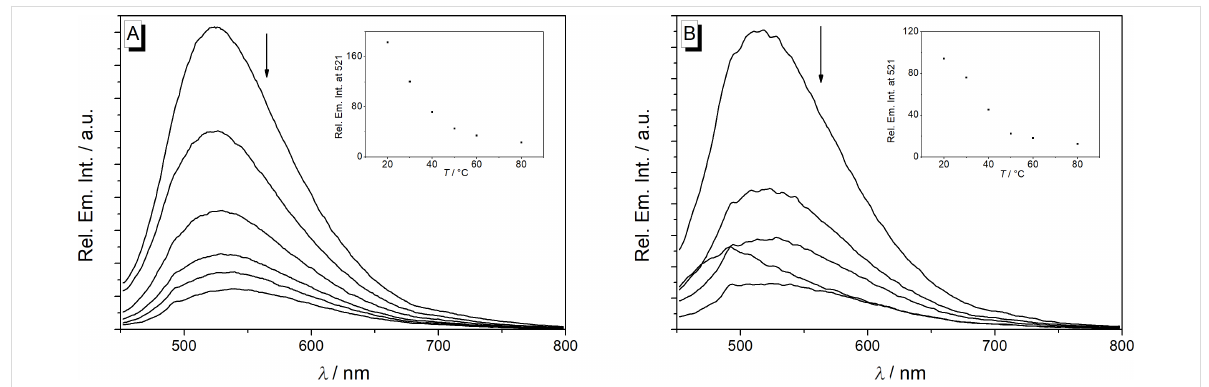
Figure 2: Temperature dependent emission spectra of derivatives 5a and 5d ( c = 10 µM, with 0.25% v/v DMSO) in glycerol; λ ex = 430 nm. The arrows indicate the changes of the emission intensity with increasing temperature. Insets: Plots of the relative fluorescence intensity versus the temperature of the solution.